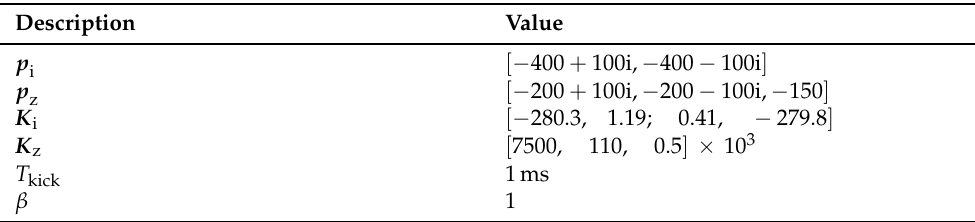
Table 4. Trajectory planning and control parameters used in simulation.